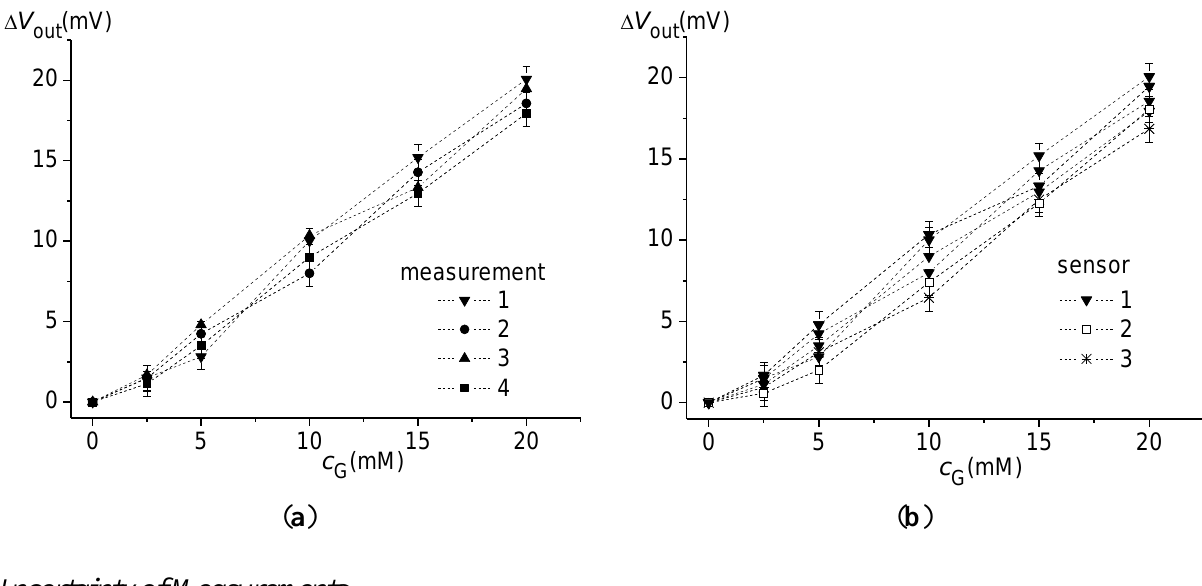
Figure B5. Output characteristics of the glucose sensors with AAm/3-AAmPBA/BIS hydrogel in PBS solutions (pH7.4, ionic strength 0.15 M) at 36.5 °C: ( a ) results of the four repeated measurements for the sensor 1 and ( b ) results for three